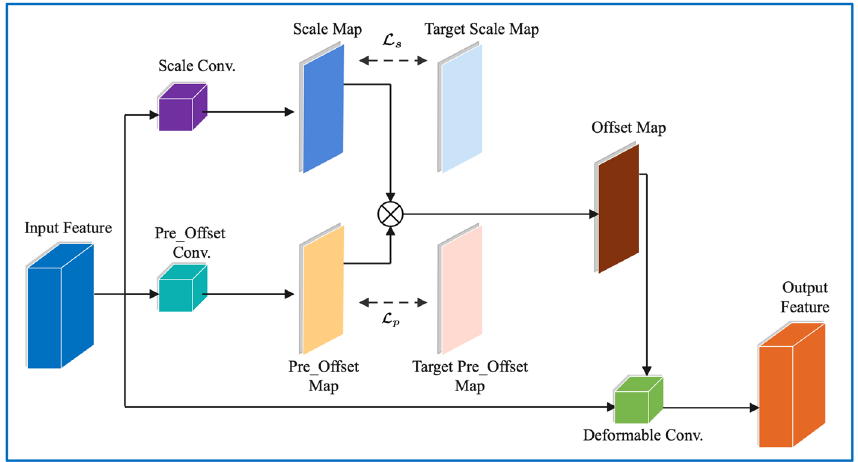
Figure 3. Illustration of our ODConv. The scale map and the pre_offset map are represented by blue and orange parallelograms, respectively. The offsets are obtained from the product of the pre_offset map and the scale map.